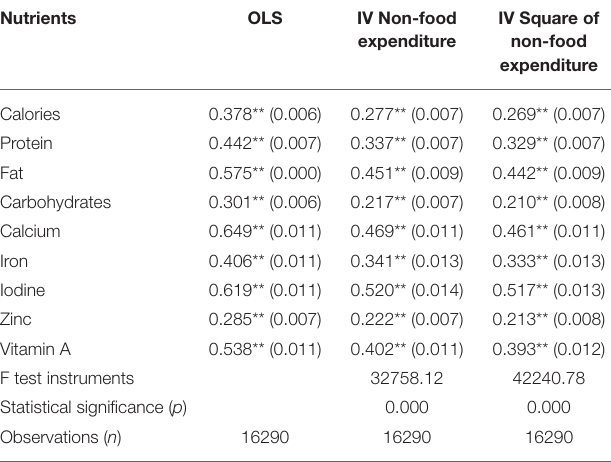
TABLE 8 | Nutrient income elasticity estimates: linear